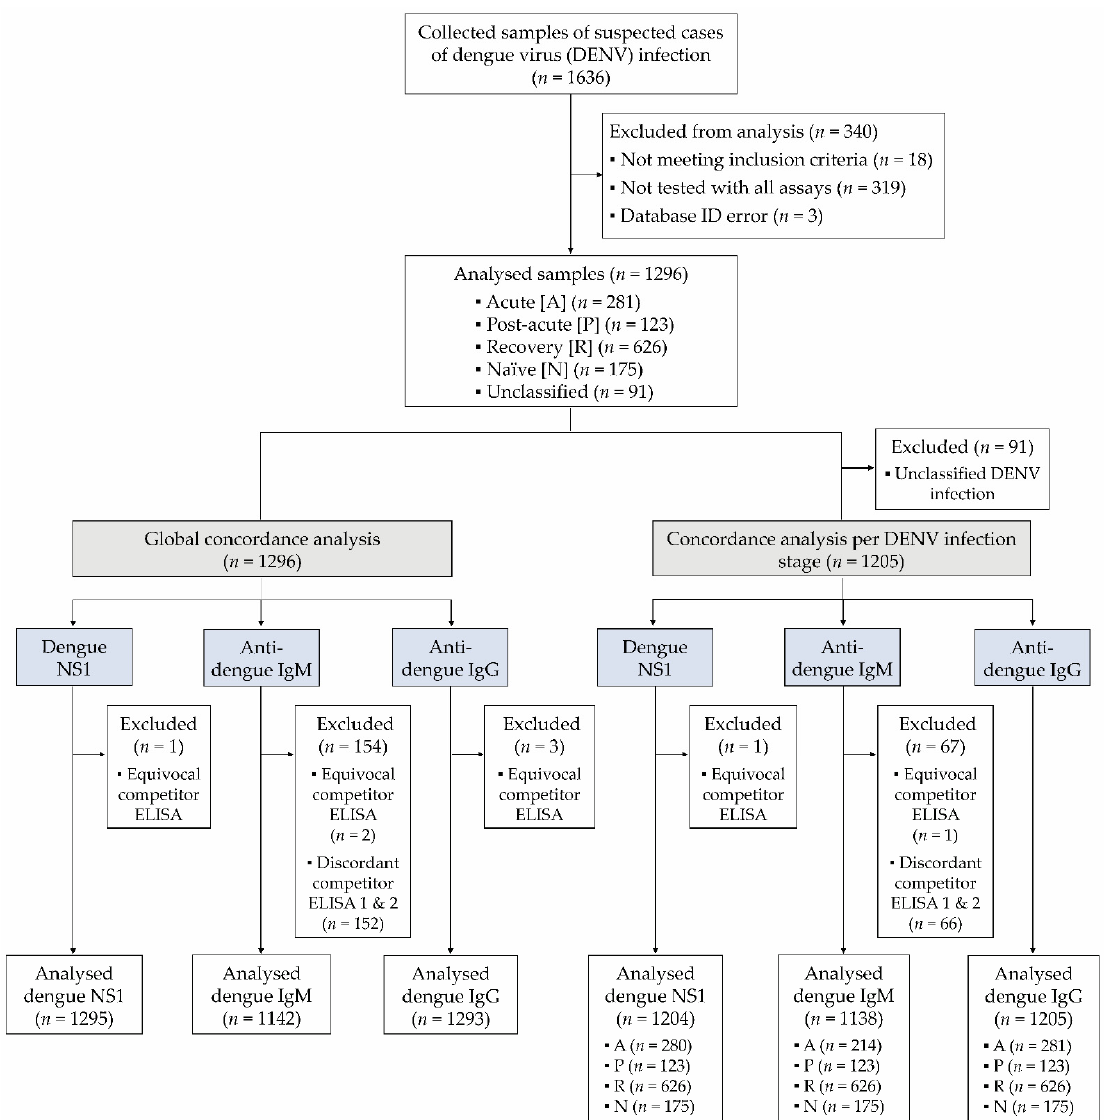
Figure 1. Study Flow diagram. A total of 1636 samples of suspected DENV infection were collected, of which 1296 eligible samples tested with all assays (competitor ELISA, VIDAS ® and PCR) were included in the analysis. Concordance analyses were conducted in the total population ( n = 1296) and according to the DENV infection stages defined in Section 2.2. ( n = 1205). An additional analysis on samples common to all immunoassays ( n = 1138) is shown in Figure S2 and Table S5.